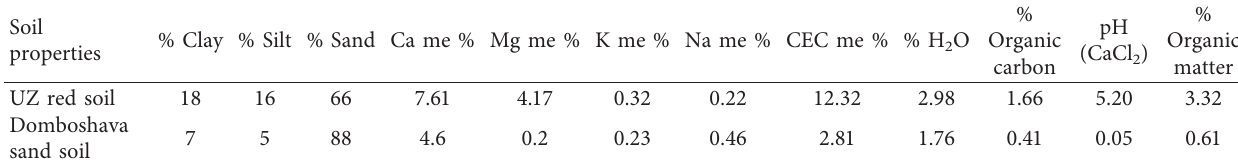
Table 1: Physical and chemical properties of soil that was used in the